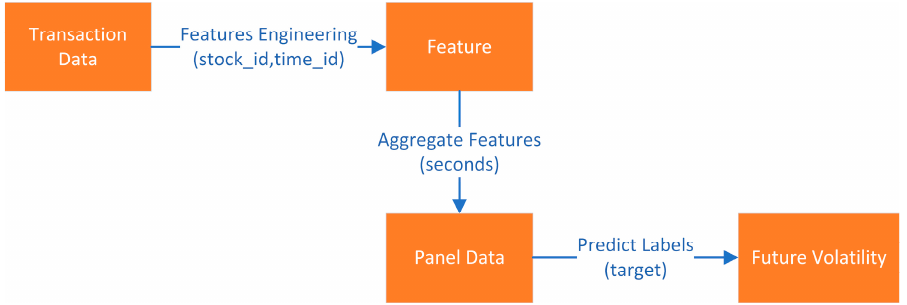
Figure 16. Feature engineering.